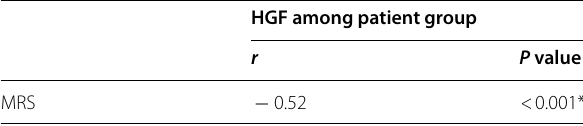
Table 15 Spearman correlation between HGF and